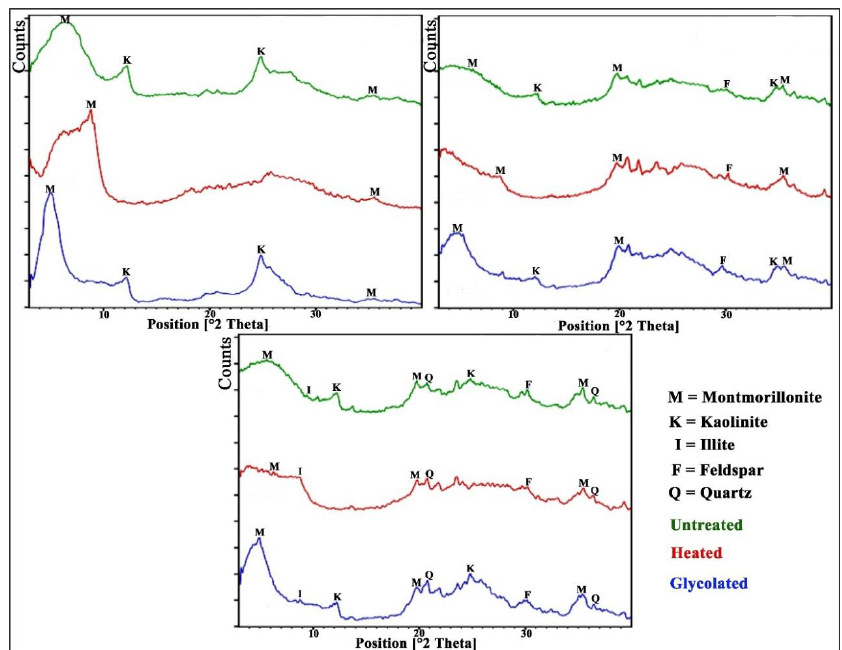
Figure 3. X-ray diffractograms of clay fraction. Atmosphere 2022 , 13 , x FOR PEER REVIEW